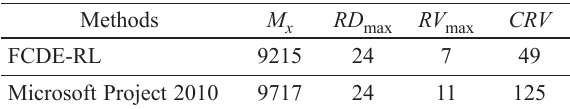
Table 5. Result comparison between FCDE-RL and Microsoft Project 2010